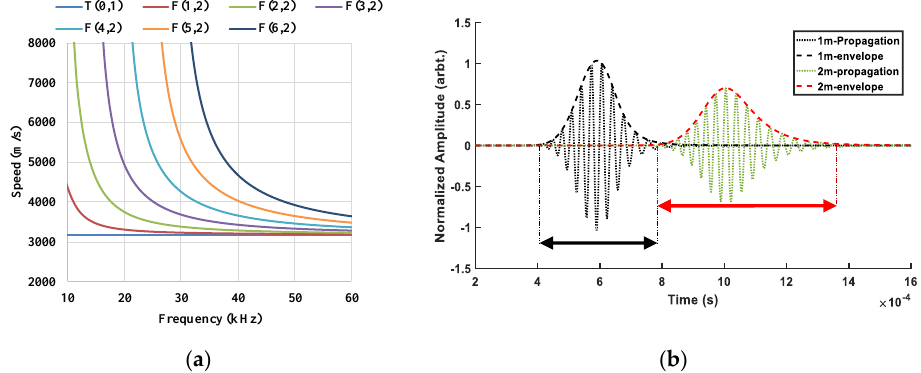
curves in Figure 2a, a simulated propagation of F(4,2) wave mode is created and shown in Figure 2b where the black and red lines show the same wave mode after 1 m and 2 m of propagation, respectively. As can be seen, for a dispersive waveform the temporal resolution and the energy of wave packet is decreased. Therefore, in general inspection, non-dispersive regions of wave modes are excited to dispersive across its whole frequency range [35]. allow ease of inspection. In this research, T(0,1) is used as the excitation wave mode since it is non- dispersive across its whole frequency range [35].